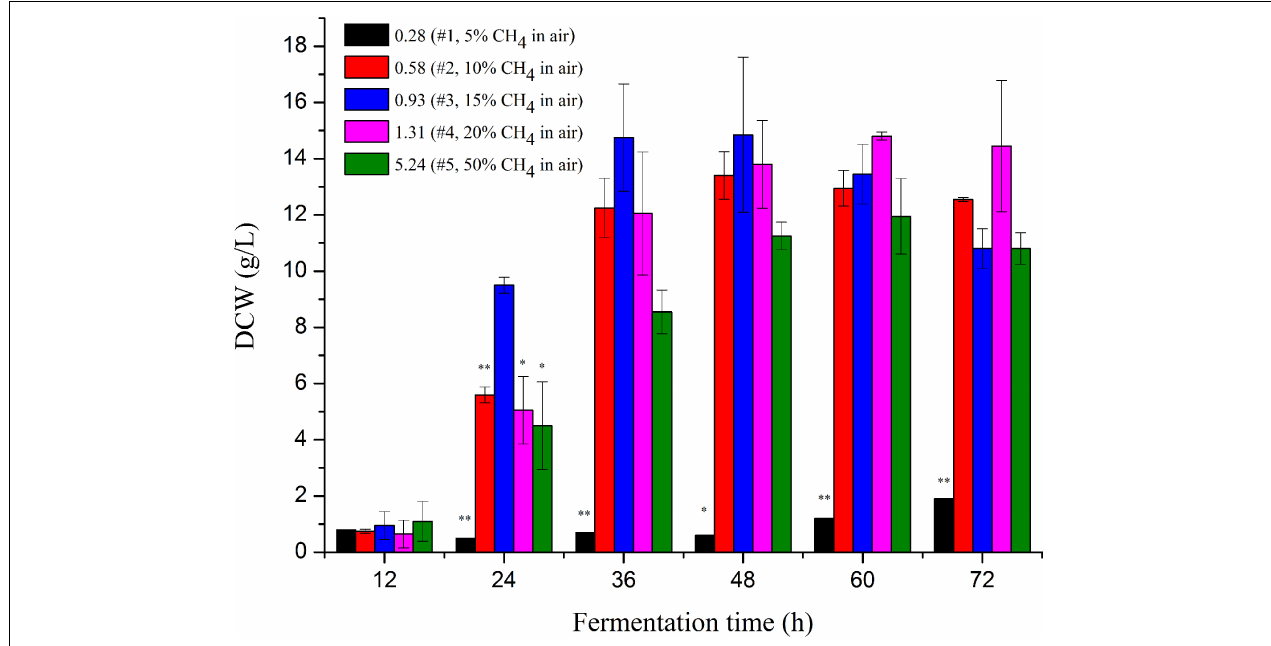
FIGURE 1 | Cell mass of M. buryatense 5GB1 in the cultures using different CH 4 /O 2 ratios of 0.28, 0.58, 0.93, 1.31, and 5.24 at different time points of 12, 24, 36, 48, 60, and 72 h post inoculation, respectively. The * and ** indicated this ratio exhibited significant difference compared to that under the CH 4 /O 2 ratio of 0.93 with statistical significance of P < 0.05 and P < 0.01, respectively. DCW, dry cell weight.